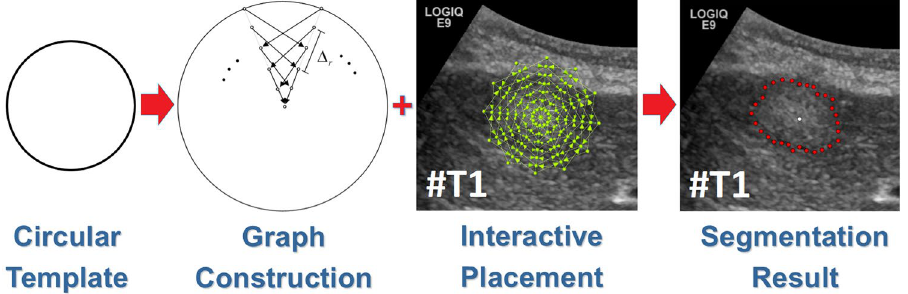
Figure 2. Interactive segmentation workflow. Left image: a circular template is used for the underlying graph. Second image from the left: based on the underlying circular template, the graph is constructed. Therefore, rays are sent out radially from the center of the circle template and along these rays the graphs’ nodes are sampled. Afterwards, intra- and inter-edges are established between these nodes (note: the inter-edges depend on a delta value Δ r ). Third image from the left: depending on the interactive placement of the mouse cursor by the user (which is also the center of the circle template/graph), the complete graph (green) is constructed at this position in the ultrasound image. Rightmost image: after the graph cut, the segmentation result (red) is displayed to the user. Note: figure adapted from 26